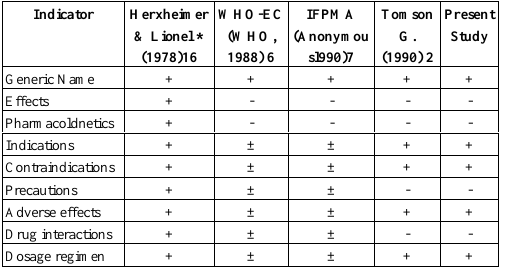
Table I : Comparative check list of indicators for drug